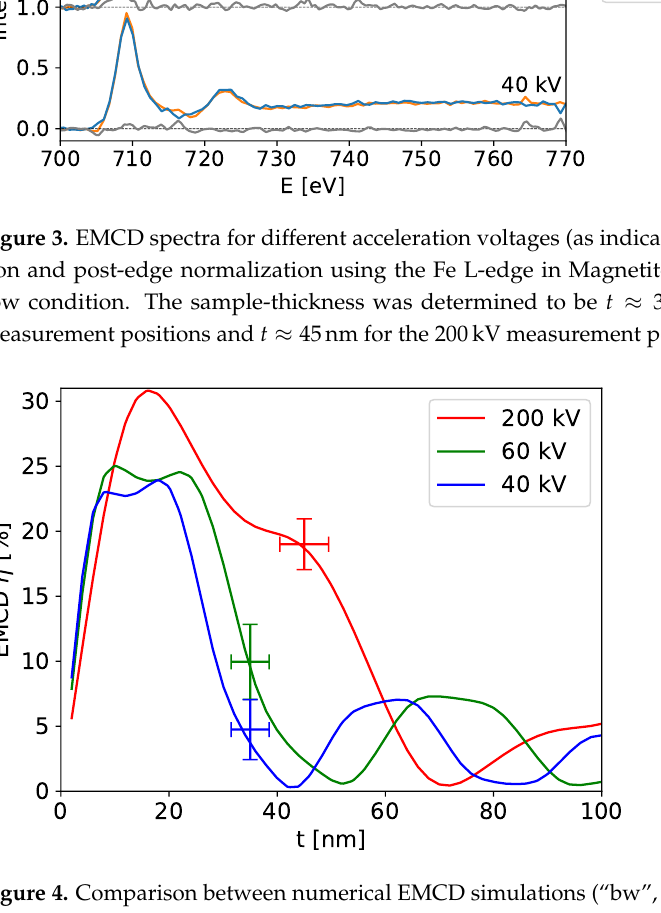
Figure 4. Comparison between numerical EMCD simulations (“bw”, solid curves) and experiments (points) for Magnetite for three different acceleration voltages. For the experimental points, η was calculated from the data in Figure 3 according to Equation (9), the measured thickness values are given in the caption of Figure 3, and the error bars were determined as described in